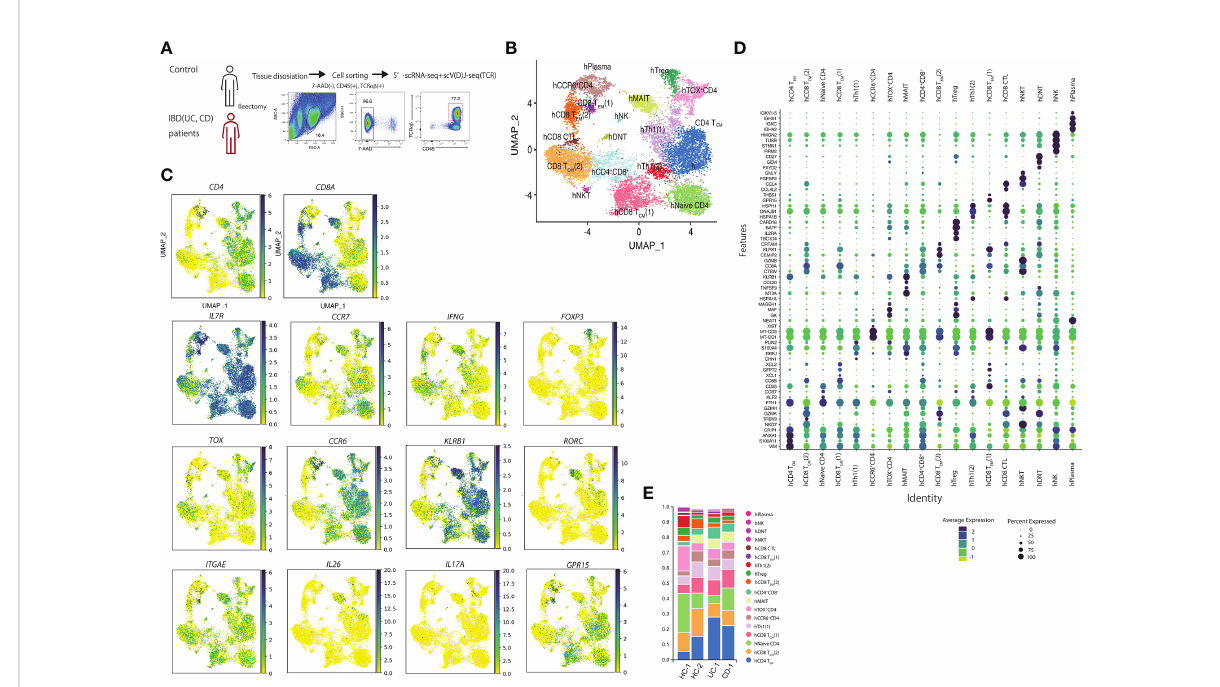
FIGURE 2 Human single-cell analysis in controls and patients with in fl ammatory bowel disease showed that cells are composed of 10 populations. (A) Sorting strategy for the human single-cell RNA-seq data: LPLs collected from digested small intestinal tissues were sorted by identifying 7AAD – CD45 + TCRB + cells by FACS. (B) Uniform manifold approximation and projection (UMAP) embedding of a total of 12,073 cells from controls (n=2) and patients with in fl ammatory bowel disease (IBD) (n=2) (7012 cells from controls, 531 cells from UC, and 4530 cells from CD patients). Cells were clustered into 18 clusters. (C) Expression of CD4, CD8A, IL7R, CCR7 , FOXP3 , IFNG , Il17A, TOX, CCR6, KLRB1, RORC, ITGAE, IL26, IL17A and GPR15 in UMAP. (D) featuring genes in human T cell clusters. (E) Proportion of each cluster in controls and patients with